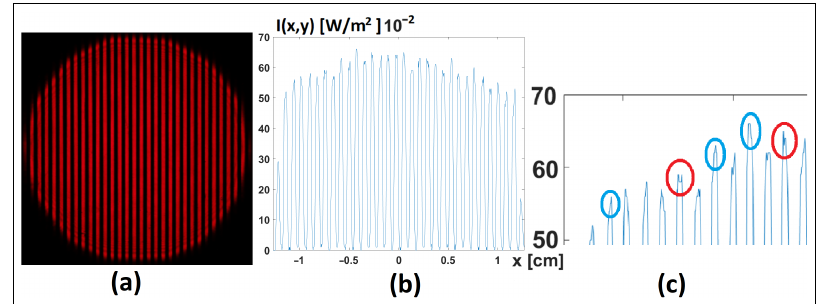
Figure 4. Experimental setups. In ( a ), intensity distribution cuts, considering a 25-lines per inch RR, in ( b ) longitudinal cut in ( a ), which we refer to as the intensity profile, and, in ( c ), zoom-in to ( b